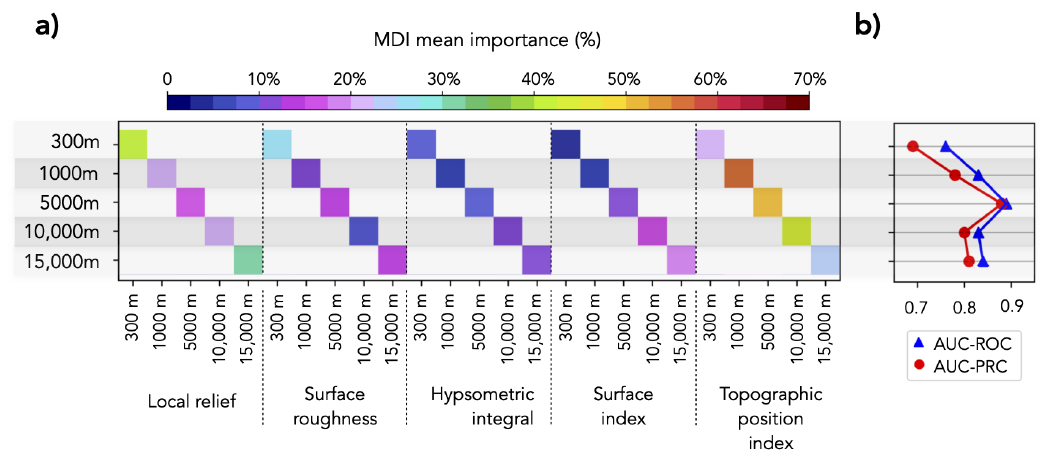
Figure 5. Fixed observation window landslide susceptibility models. Each model includes the window-based morphometric indices: local relief, surface roughness, hypsometric integral, surface index, and topographic position index computed at a fix and unique observation window. We selected fixed observation windows size of ∼ 300 m, ∼ 1000 m, ∼ 5000 m, ∼ 10,000 m and ∼ 15,000 m. ( a ) MDI mean importance for the predictive variables included in the models. ( b ) Evaluation metrics: mean area under the receiver operator curve (AUC-ROC) and mean area under the precision-recall curve (AUC-PRC) from 50 iterations of the same model while using random selection of the training